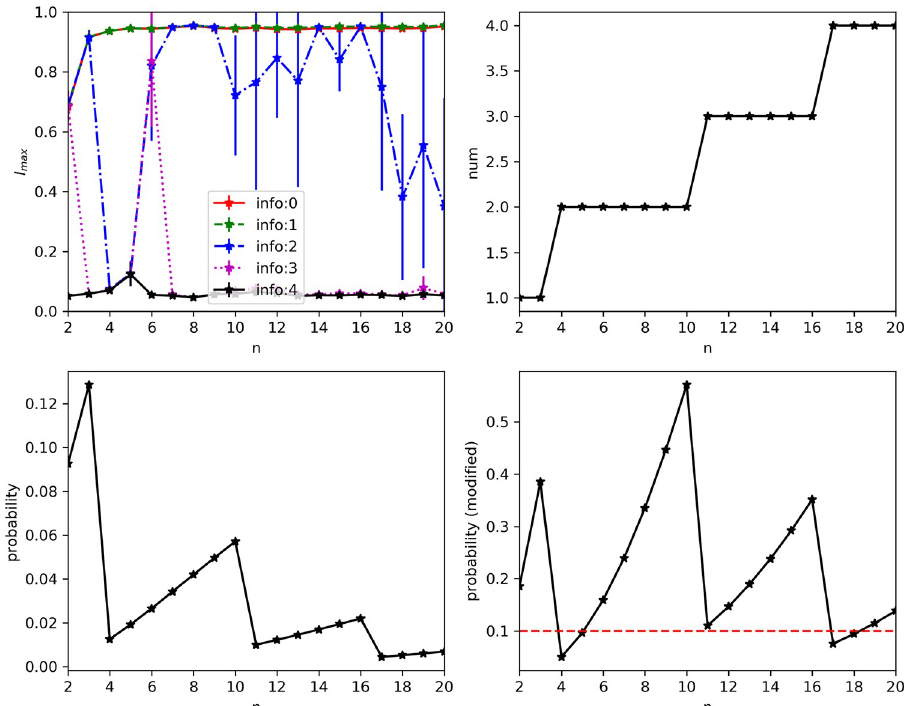
Fig 7. (a) the evolution tendency of each information’s I max with different neighbor number n . (b) the minimum necessary number of I node among neighbors when No.2 information can successfully spread. (c) the total spreading probability of No.2 information with initial parameter setting for different neighbor number. (d) the modified spreading probability (the total spreading probability multiply neighbor number) of No.2 information with benchmark initial parameter setting for each node in different neighbor